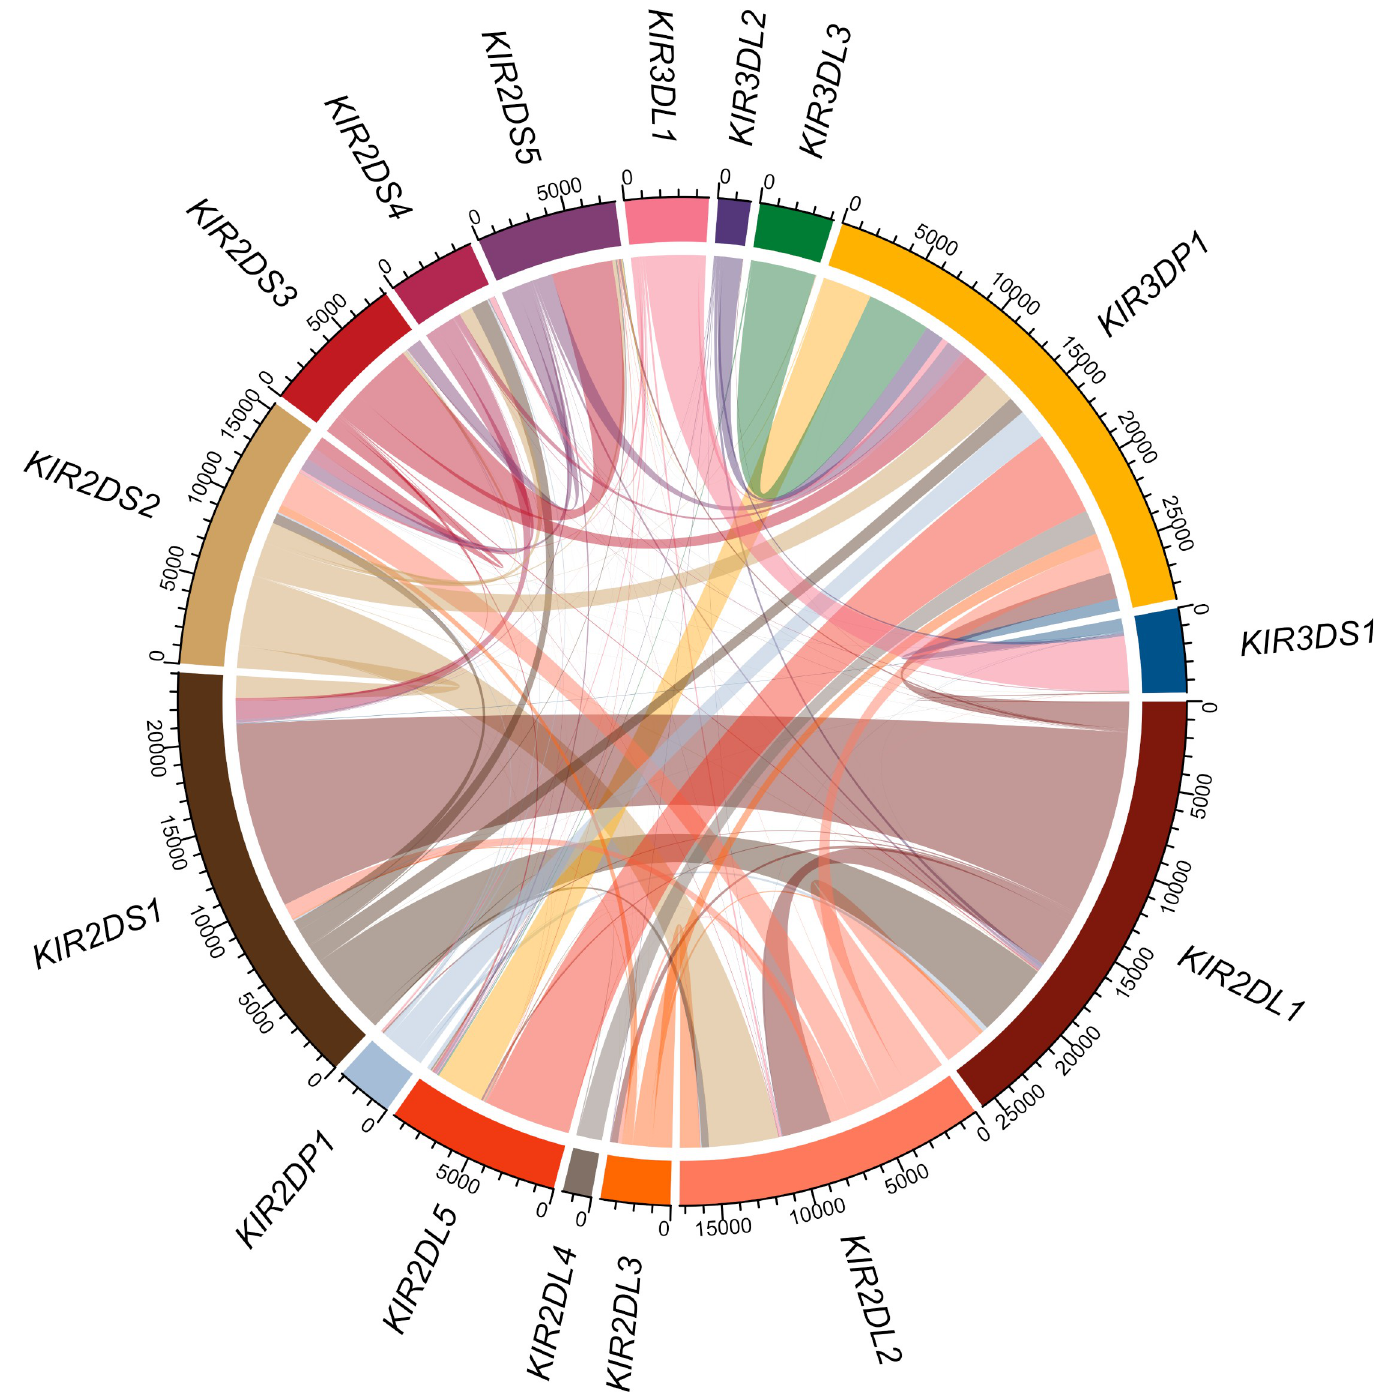
Fig 6. Misaligned read sources in the synthetic dataset. Analysis of mismatched or unresolved genotype determination results for the synthetic sequence dataset where all misaligned reads are traced back to their source gene. The connections between genes represent the number of misaligned reads, and the color of the connection represents the source